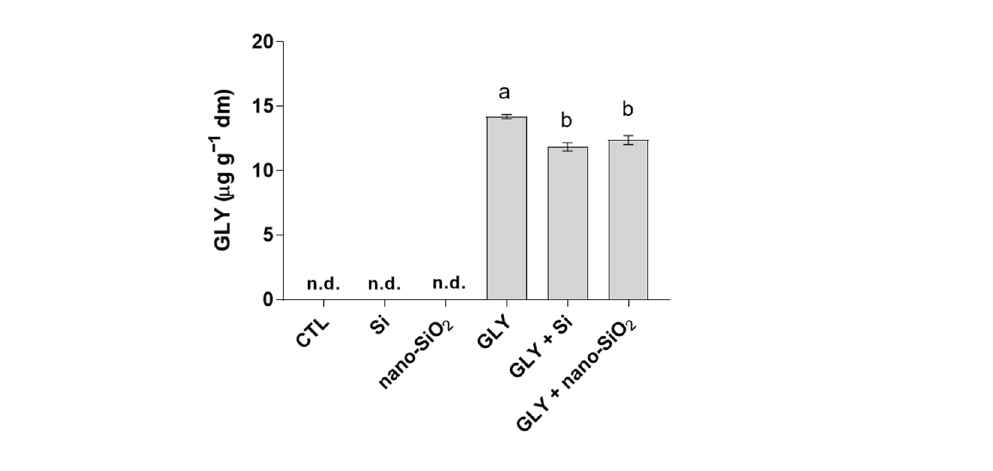
Figure 8. GLY levels in roots of S. lycopersicum plants after 4 weeks of growth. n.d.: non-detected, which means below the detection limit. Data presented are mean ± STDEV ( n ≥ 3). Different letters (a–b) above bars indicate significant statistical differences between treatments (Tukey: p ≤ 0.05).